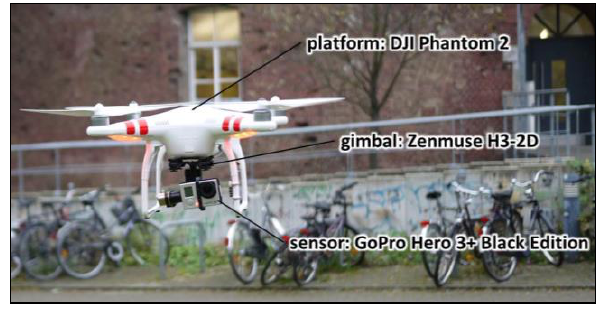
Figure 2: Platform and sensor used in this study